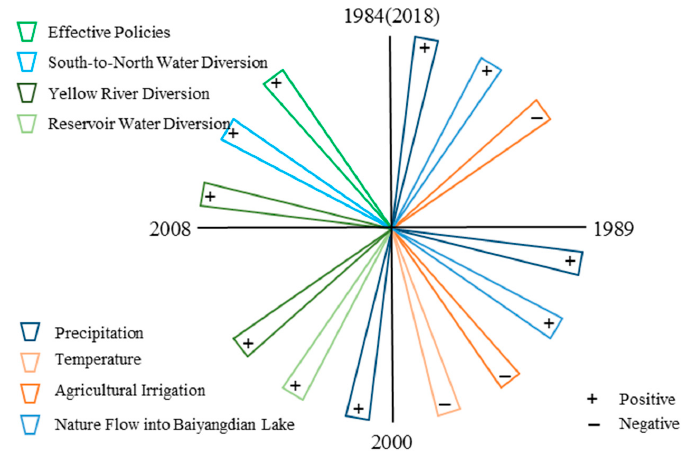
Figure 18. The possible causes for the change in water area in Baiyangdian Lake during the four periods. + indicates that this factor is positively correlated with the change in water area, and − indicates that the factor is negatively correlated with the change in water area.